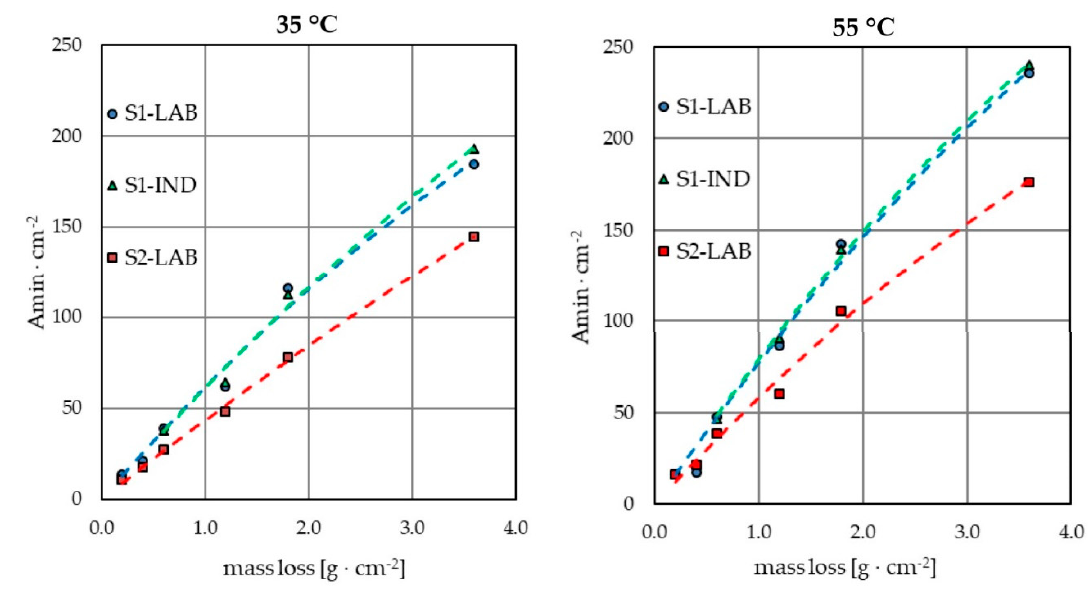
Figure 2. Electric load per unit as a function of sample weight loss per unit after electropolishing in baths containing 3% mass Fe.